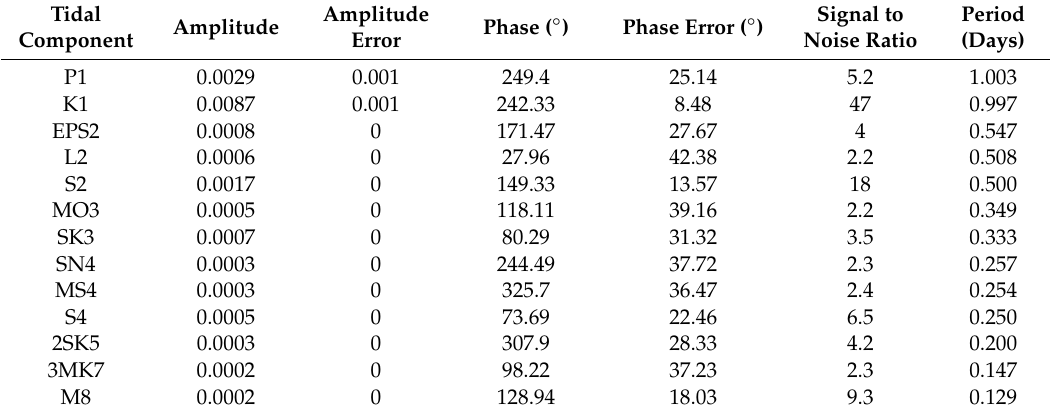
Table 3. T_Tide analysis for period 2019. Tidal constituents’ amplitude and phase with 95% CI estimates; phases are at central